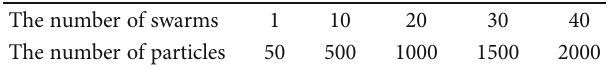
Figure 18: The paths of 50 Monte Carlo simulations at 200 iterations for long-range test cases. Table 6: The relations between the number of swarms and the total number of particles used for the multi-swarm PSO